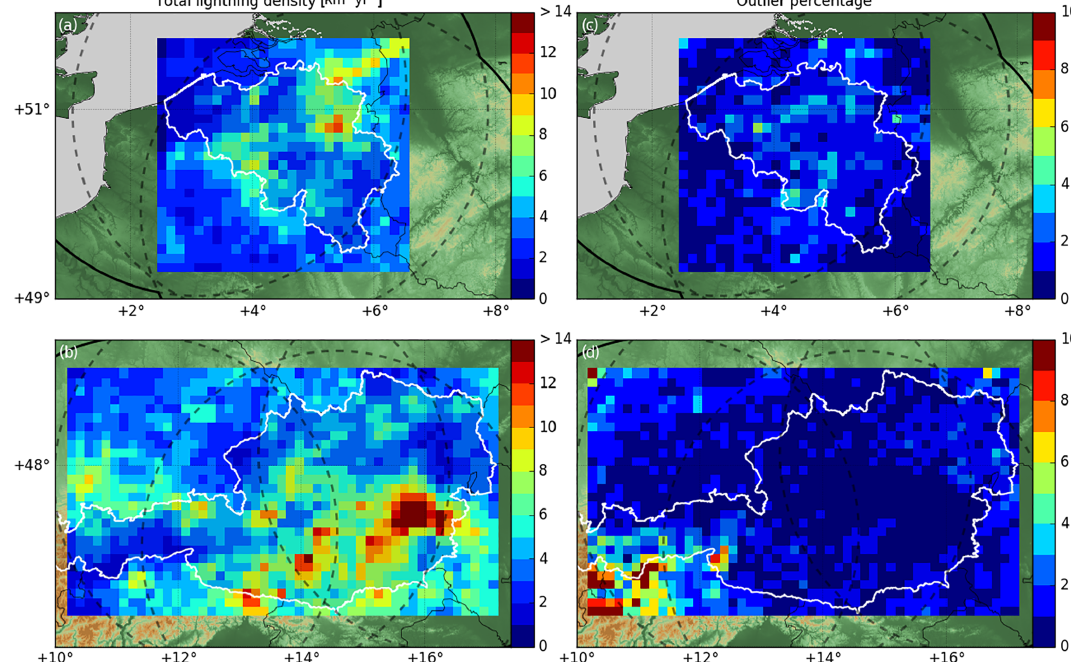
Figure 5. Panels (a, b) display the 6-year mean annual total lightning event (CG strokes + IC pulses) density on a 10km 2 × 10km 2 grid in Belgium (top) and Austria (bottom), whereas the spatial distribution of the total percentage of outliers is plotted in (c, d) for an adopted search radius of